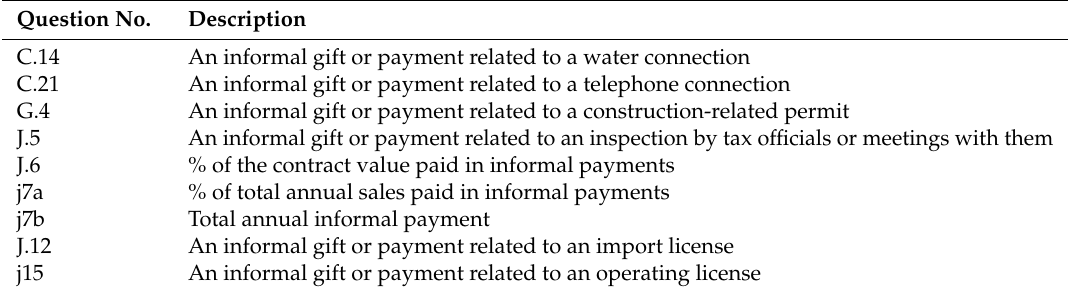
Table 3. Survey questions related to dependent variable ( CORRUPTION